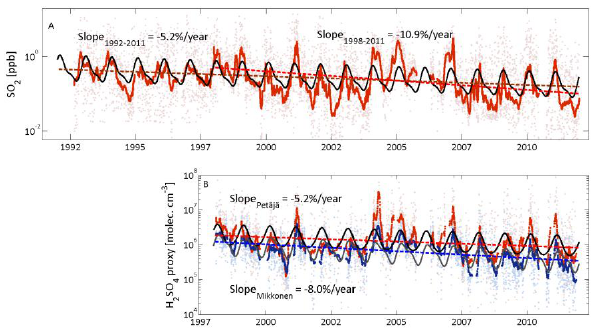
Fig. 10. 1-day averages (dots) and 30-day sliding average (thick line) of SO 2 (1992–2011) (A) and H 2 SO 4 proxy (1998–2011), for Figure 10 1-day averages (dots) and 30-day sliding average (thick line) of SO 2 (1992-2011) 5 proxies Petäjä (red) and Mikkonen (blue) (B) , respectively. Sinu- (A) and H 2 SO 4 proxy (1998-2011), for proxies Petäjä (red) and Mikkonen (blue) (B), 6 soidal seasonal fits with linear trend as well as linear fits to the log- respectively. Sinusoidal seasonal fits with linear trend as well as linear fits to the logarithmic 7 arithmic data are shown as data are shown as well. 8